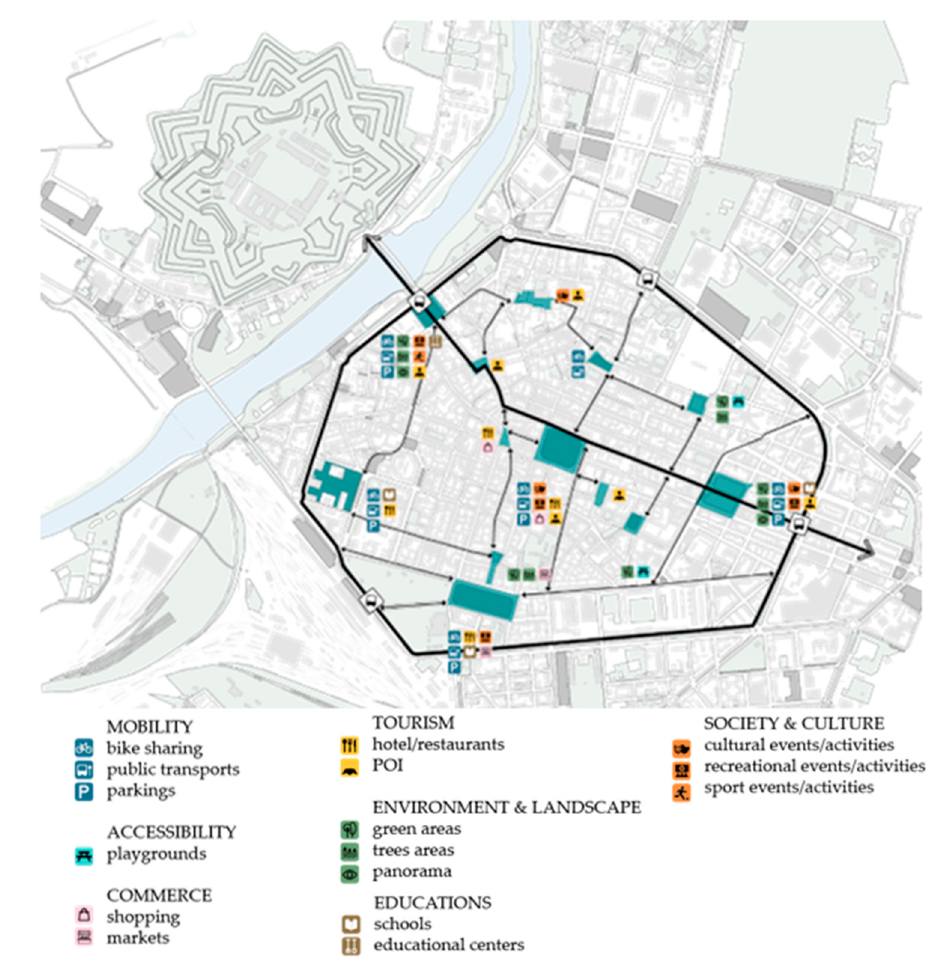
Figure 8. The proposed meta-design with the East–West backbone, the network of pathways that reconnects the squares, and the proposed functions [Sources: Authors, OpenStreetMap, Municipality of Alessandria].